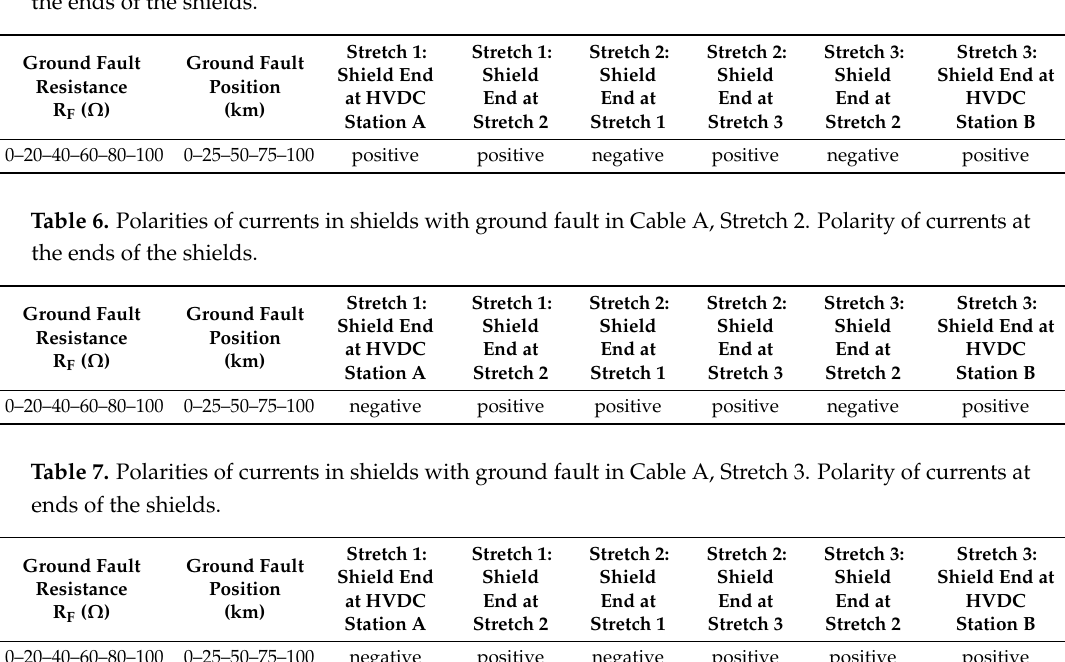
Table 5. Polarities of currents in shields with ground fault in Cable A, Stretch 1. Polarity of currents at the ends of the shields.